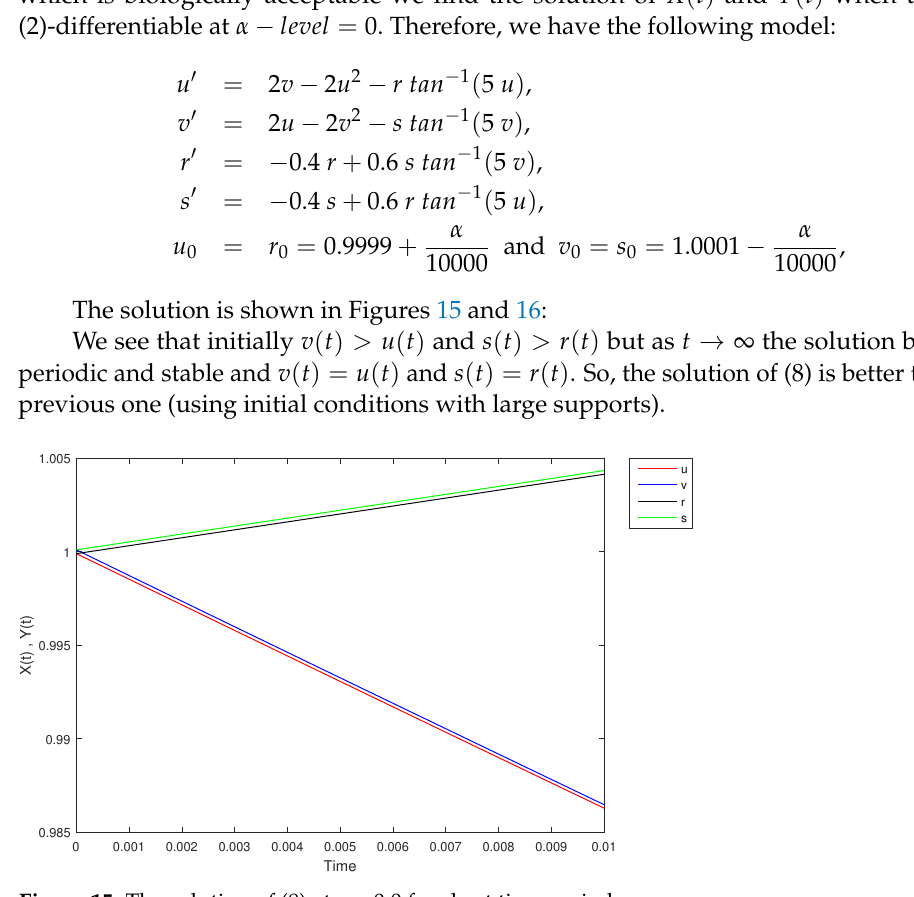
Figure 15. The solution of (8) at α = 0.0 for short time period.